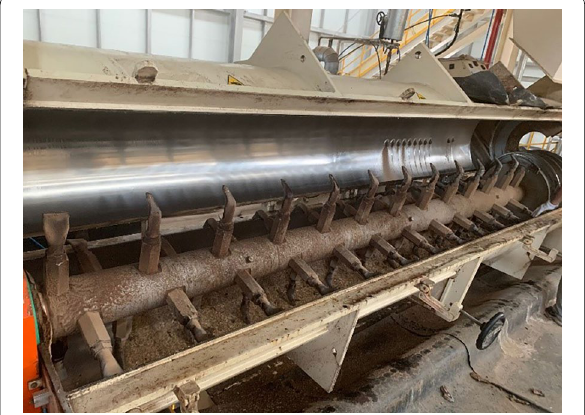
Fig. 2 Internal structure of the blender in particle gluing